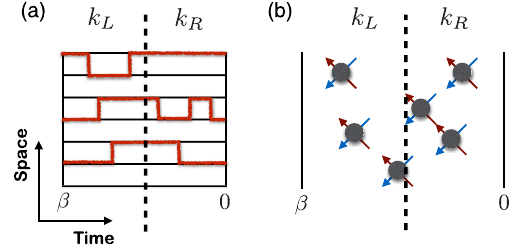
FIG. 2. (a) Measurement of the fidelity susceptibility in a continuous-time worldline QMC simulation of bosons and quantum spins, where one counts the number kinks k L and k R after division of the imaginary-time axis. (b) In the diagrammatic determinantal QMC simulation of correlated fermions, the number of interaction vertices k L and k R are